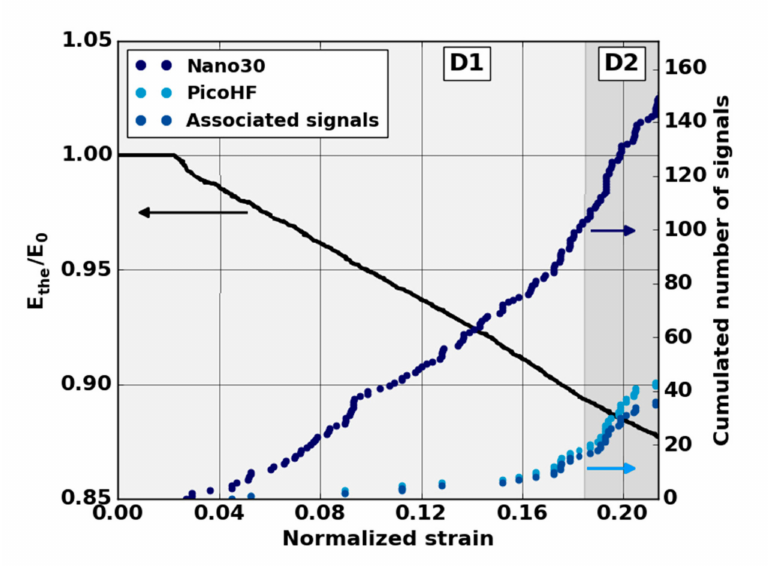
Figure 11. Evolution of the normalized modulus and cumulated number of AE signals recorded from each and both sensors versus strain during the domain D1 of macroscopic tensile test in the fiber